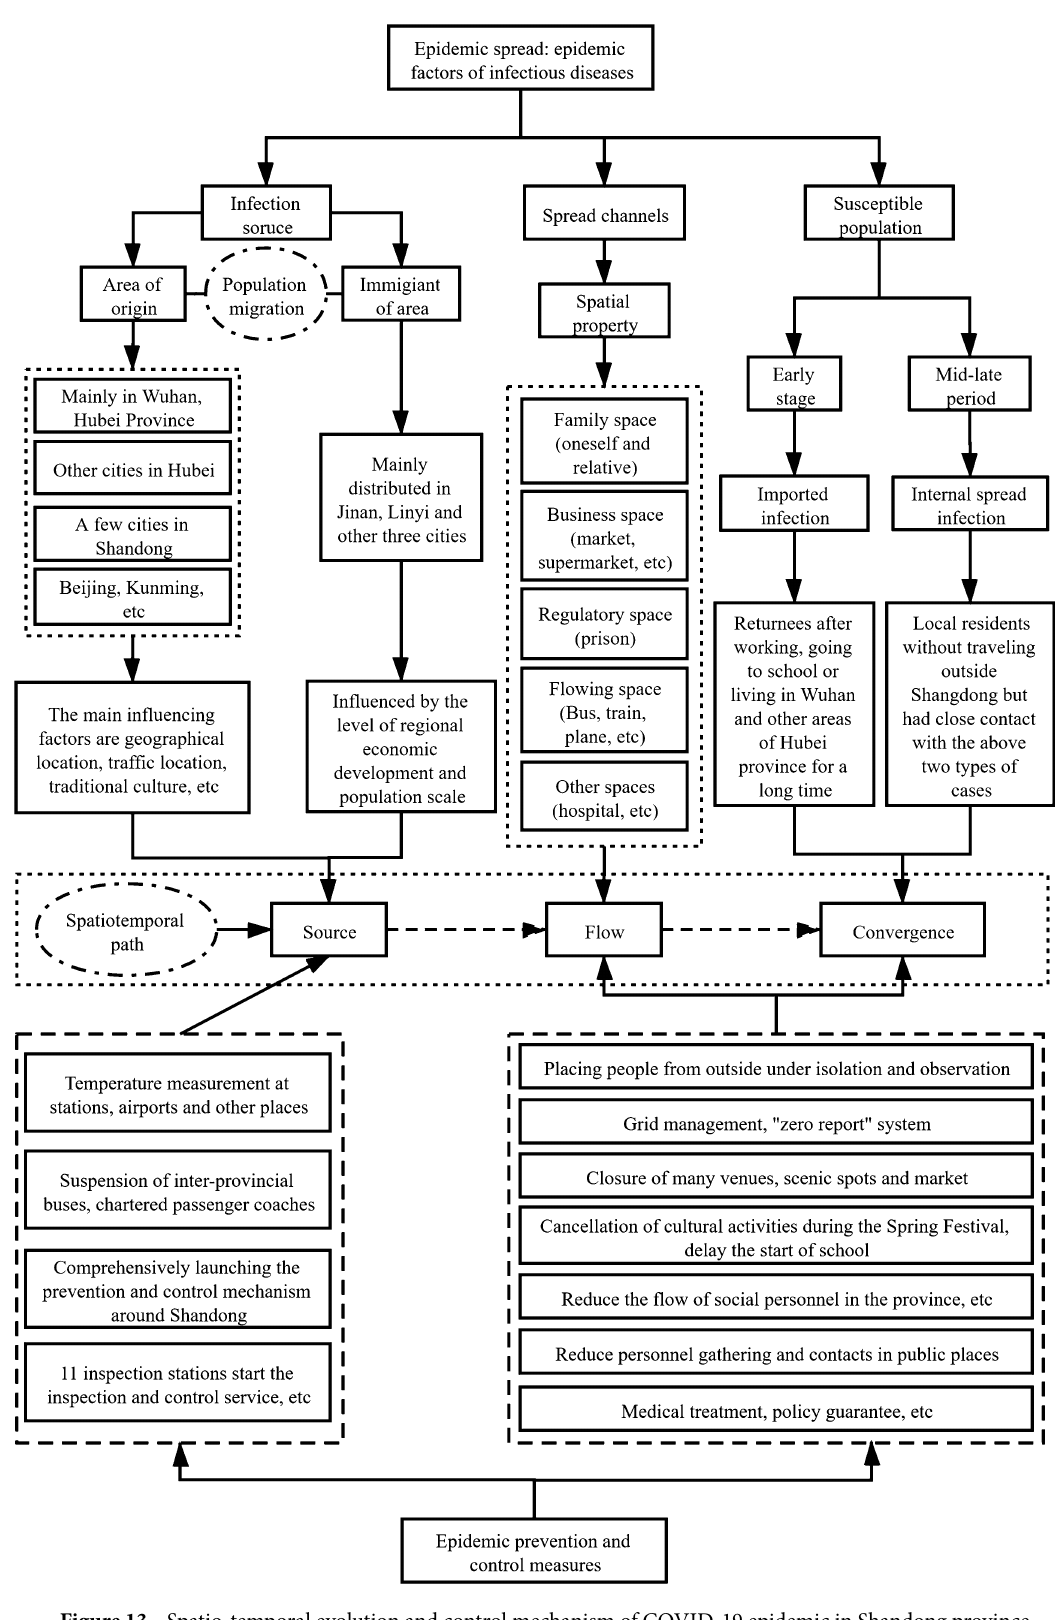
Figure 13. Spatio-temporal evolution and control mechanism of COVID-19 epidemic in Shandong